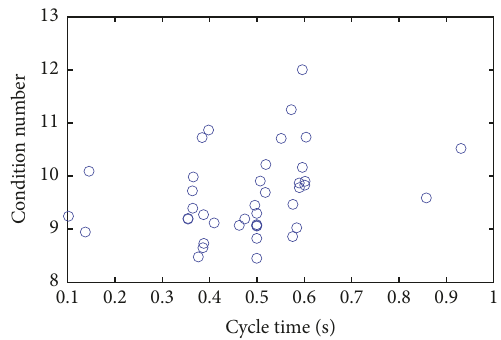
Figure 9: Scatter plot of cycle time, occupied area and condition number in the